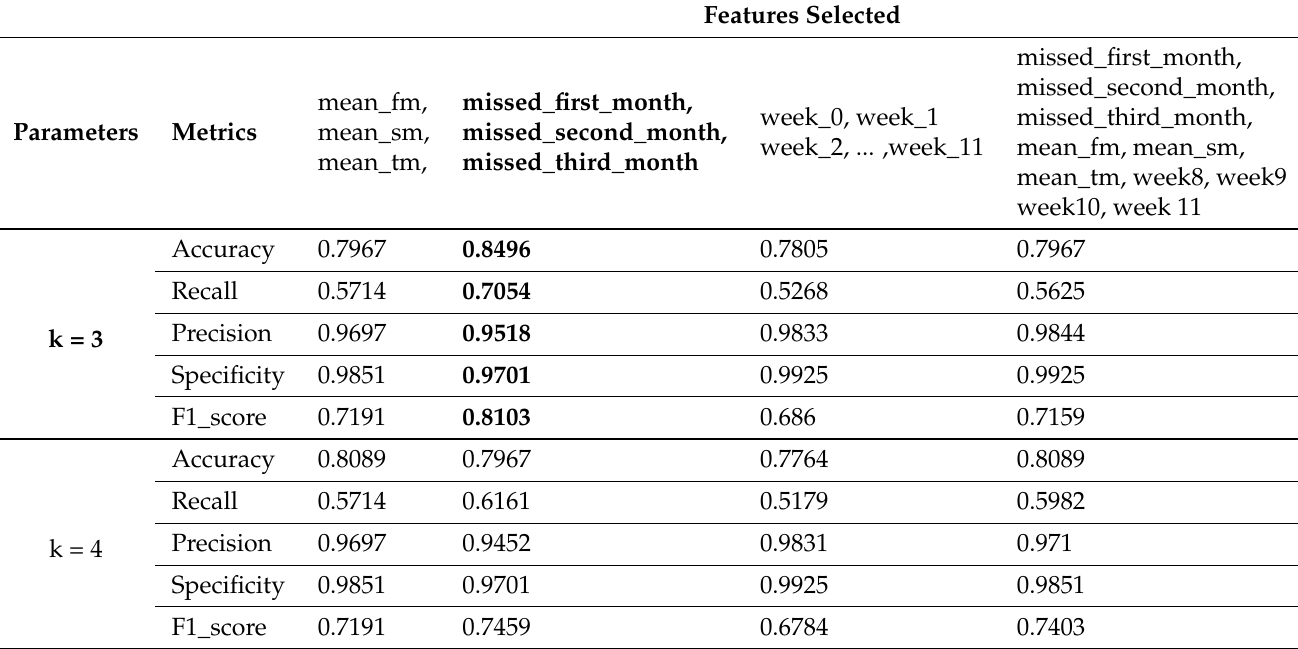
Table 17. Metrics, applying different configurations for k-means clustering—LSTM. Features